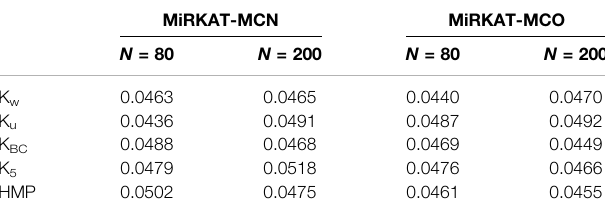
TABLE 1 | Empirical type I error rates of MiRKAT-MC for independent data with three-categories. MiRKAT-MCN MiRKAT-MCO